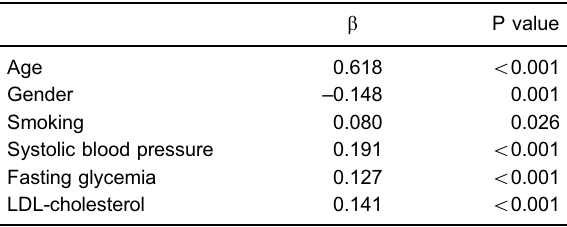
Table 5. Variables independently associated with mean C-IMT identi fi ed by multiple linear regression